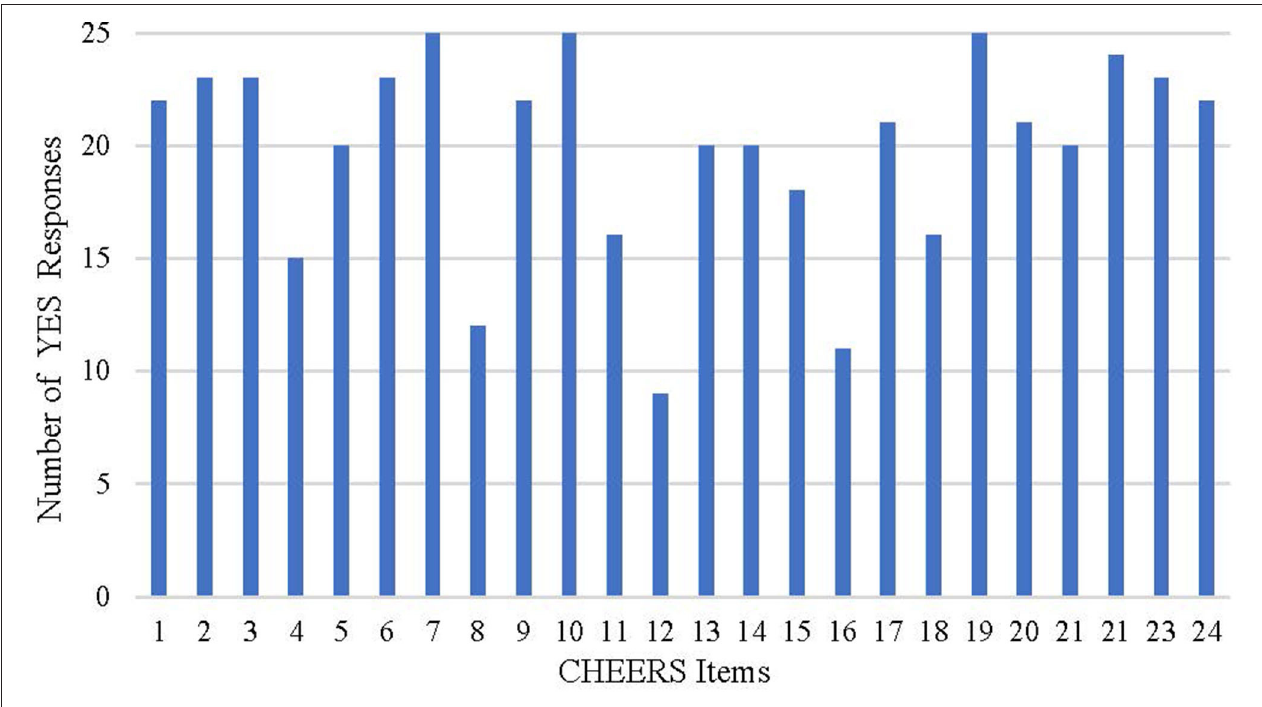
FIGURE 3 | Results of the assessment with CHEERS